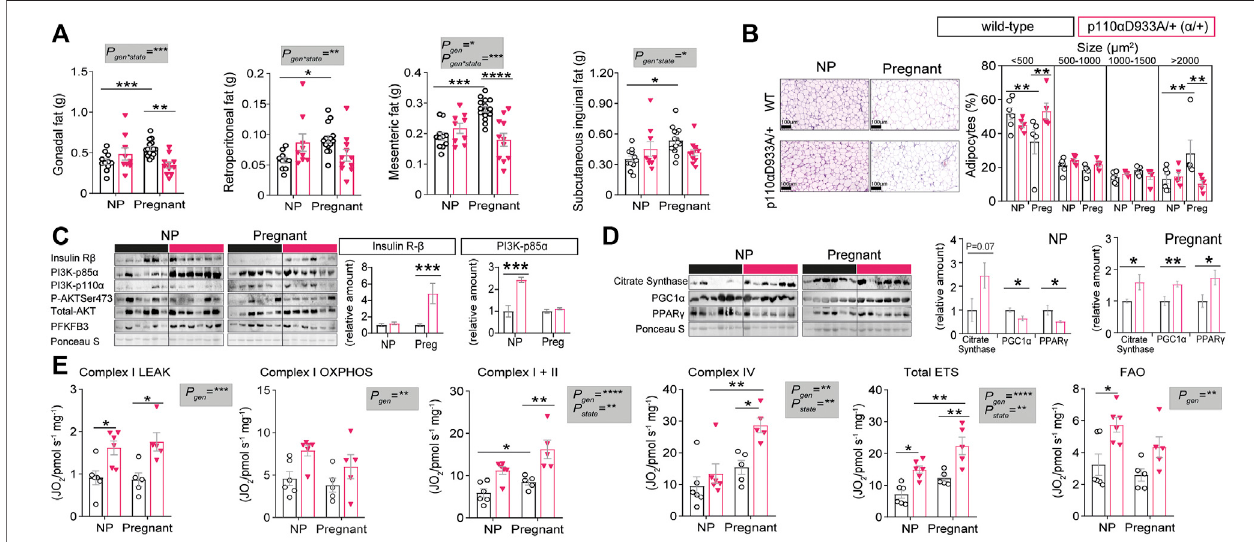
FIGURE 3 | PI3K-p110 α regulates adiposity levels and mitochondrial function. (A) Adipose depot weights in non-pregnant (NP) and pregnant mice ( n = 9 – 15/ group; two-way ANOVA). (B) Histological analysis of adipocyte size ( n = 5 – 6/group; two-way ANOVA) (scale bar = 100 μ m). (C) Western blot analysis of metabolic signalling proteins: insulin receptor β subunit (Insulin R β ), phosphoinositide-3-kinase subunits (PI3K-p85 α and PI3K-p110 α ), total and phosphorylated protein kinase B (TotalAKTandP-AKTSer473)and6-phosphofructo-2-kinase/fructose-2,6-biphosphatase3(PFKFB3).( n =6/group;un-pairedStudent ’ s t -test). (D) Western blot analysisofmitochondrialrelatedproteins;citratesynthase,peroxisomeproliferator-activatedreceptorgammacoactivator1-alpha(PGC1 α )andperoxisomeproliferator- activated receptor gamma (PPAR- γ ). ( n = 6/group; un-paired Student ’ s t -test). (E) Mitochondrial respiration rates. Information about substrate/inhibitor in relation to complex activation can be found in Supplementary Table S1 . Maximum electron transfer system capacity (Total ETS) and fatty acid oxidation (FAO). ( n = 5 – 6/group; two-way ANOVA). Data in (B – E) are from the retroperitoneal fat pad. Data are individual values and/or mean ± SEM. * p < 0.05; ** p < 0.01; *** p < 0.001; **** p < 0.0001.